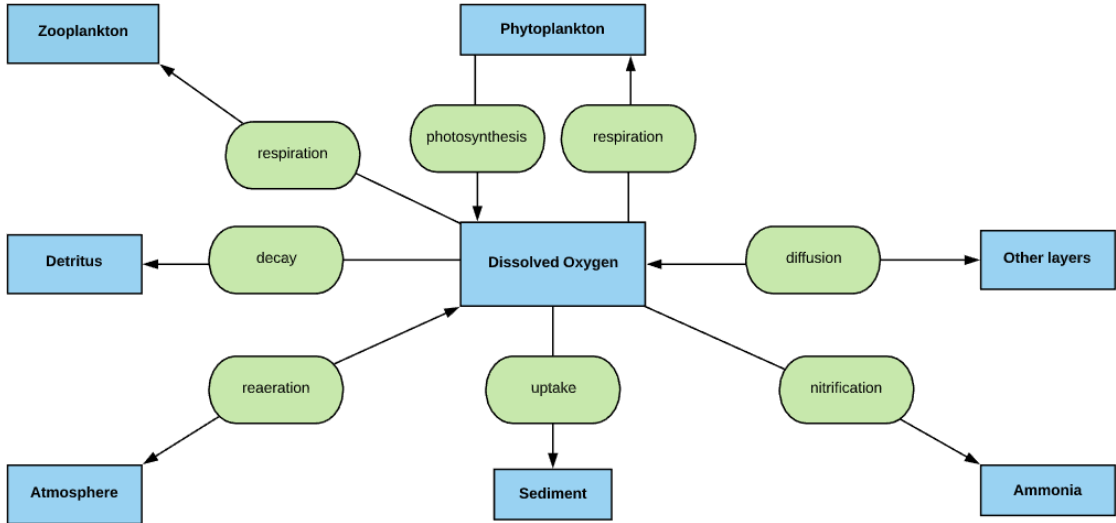
Figure 7. Schematic diagram of DO cycle modeled by MINLAKE2020.